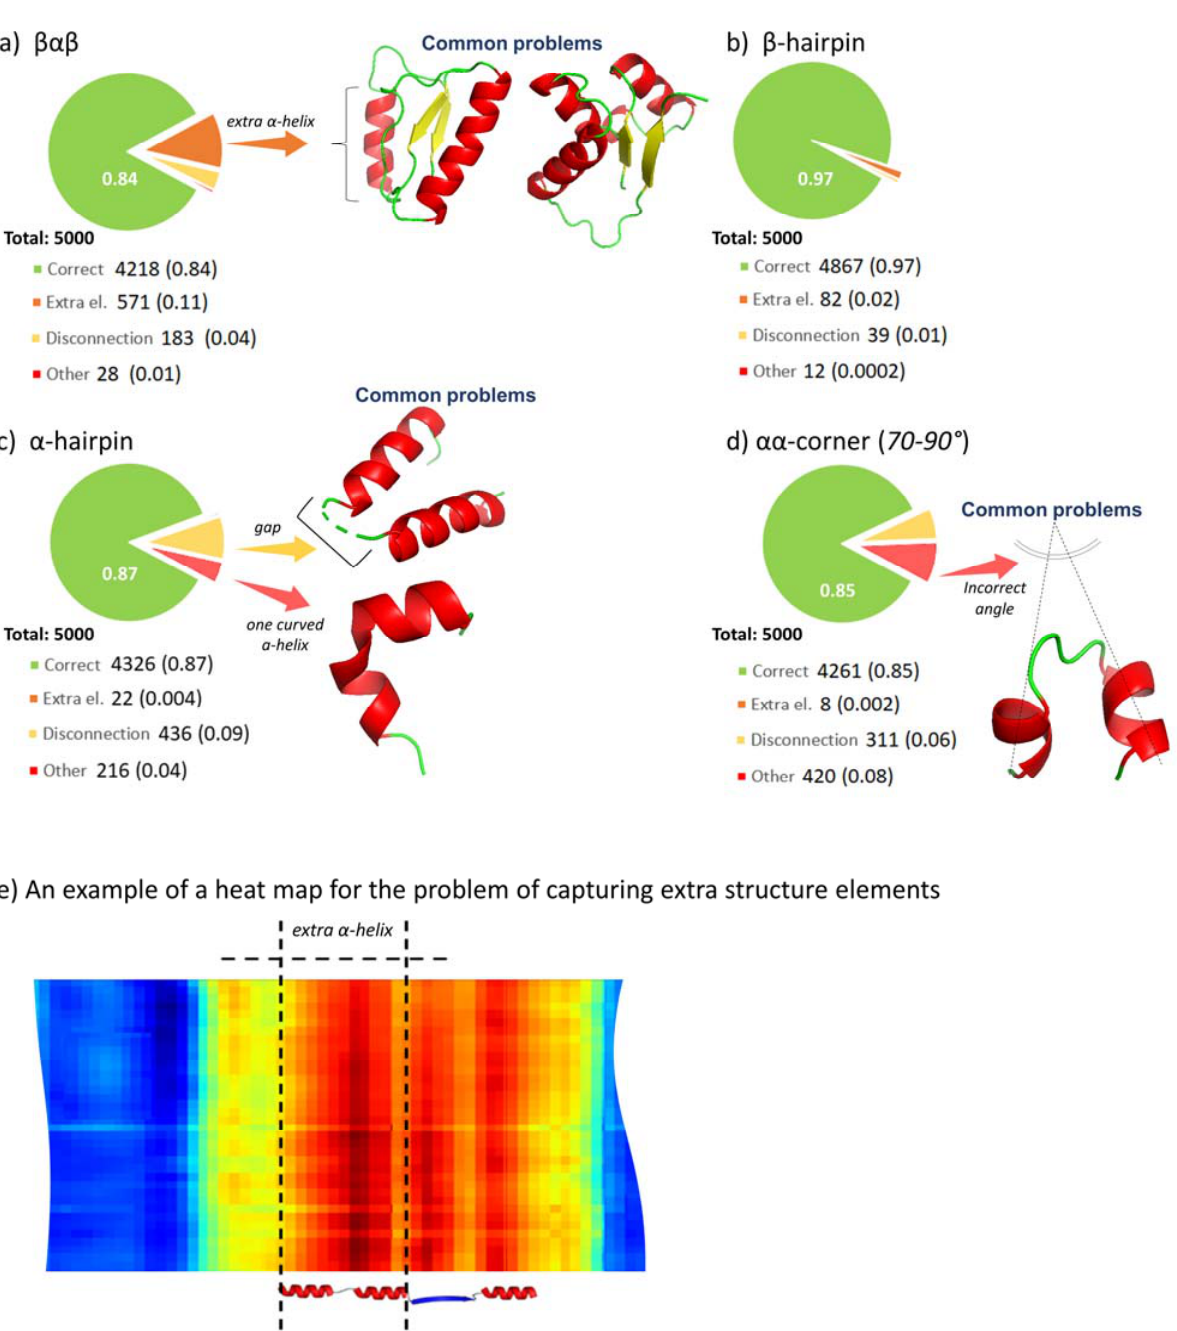
Figure 1. Evaluation of the model on empirical consolidated datasets (random sampling of 5000 elements for each type of SSS) of ( a ) βαβ‐ unit, ( b ) β‐ hairpin, ( c ) α‐ hairpin and ( d ) αα‐ corner, ( e ) heat ments for each type of SSS) of ( a ) βαβ -unit, ( b ) β -hairpin, ( c ) α -hairpin and ( d ) αα -corner, ( e ) heat map for the problem of extra α‐ helix. map for the problem of extra α